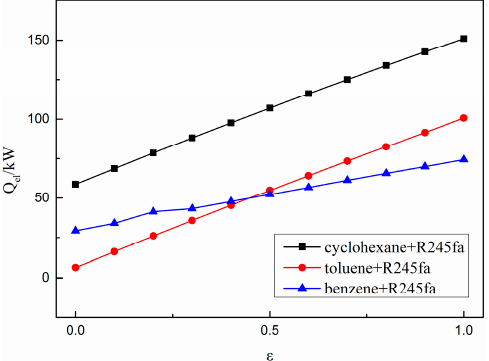
Figure 4. Effect of regenerator efficiency on heat absorption of low temperature cycle evaporator.